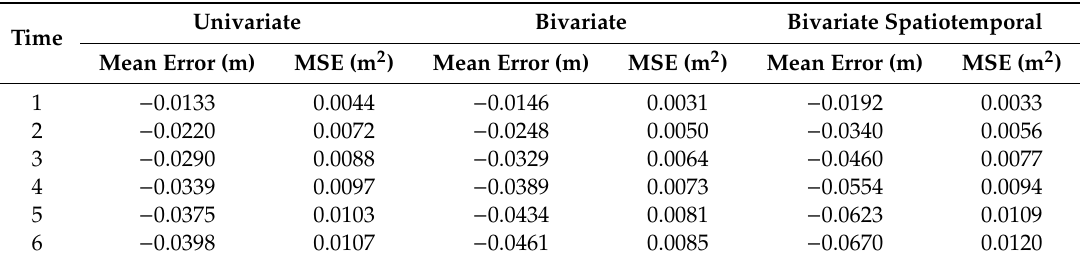
Table 9. Errors of simulated hydraulic